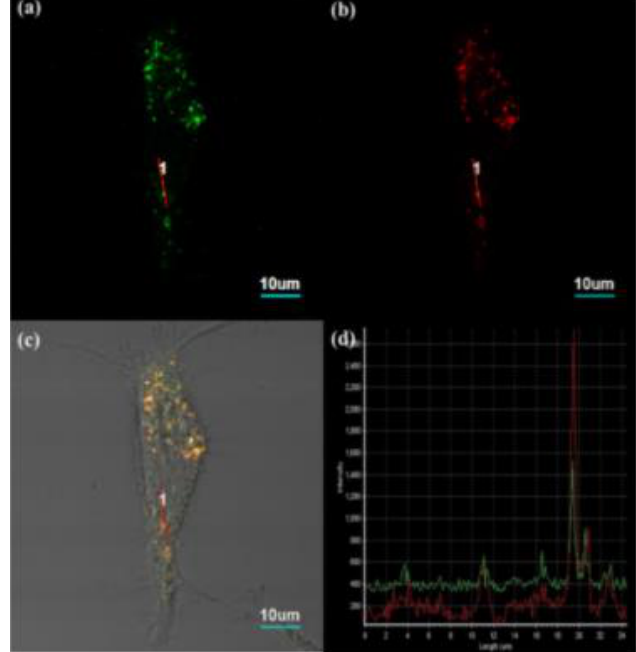
Figure 6. Two-photon exciting fluorescence (TPEF) image of ovarian cancer cells: ( a ) Fluorescence TPEF image using β-Galactosidase (β-gal) probe; ( b ) image using Lyso Tracker Red probe; ( c ) overlay of images a and b; ( d ) intensity profile (taken from [27] with permission).